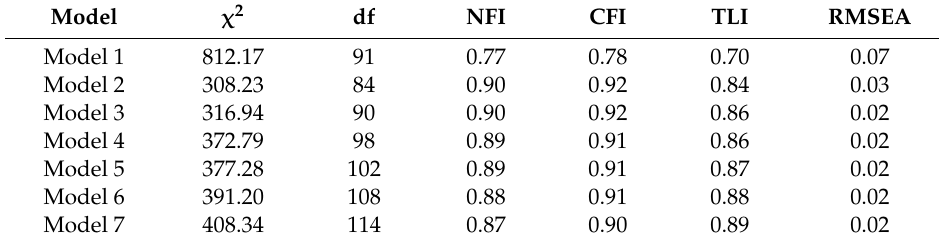
Table 4. Model fitness comparison.